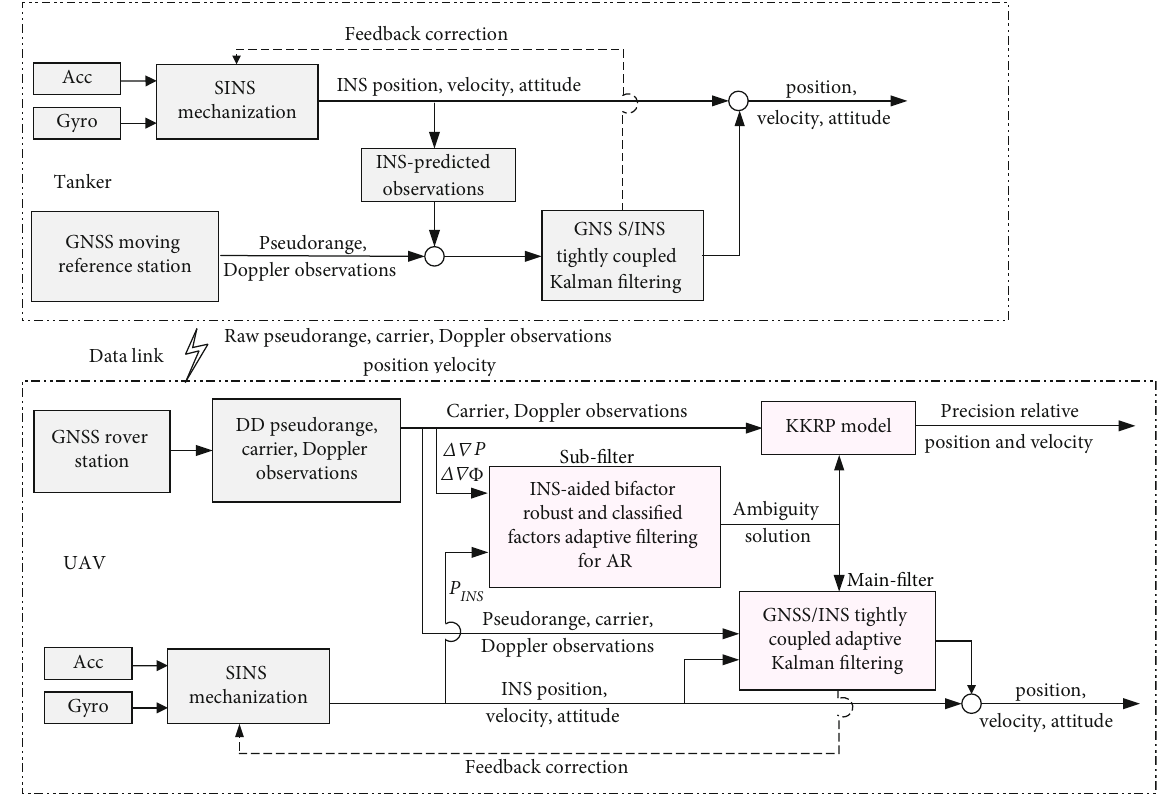
Figure 1: The algorithm roadmap of the two-stage adaptive fi ltering architecture for precise KKRP in AAR.